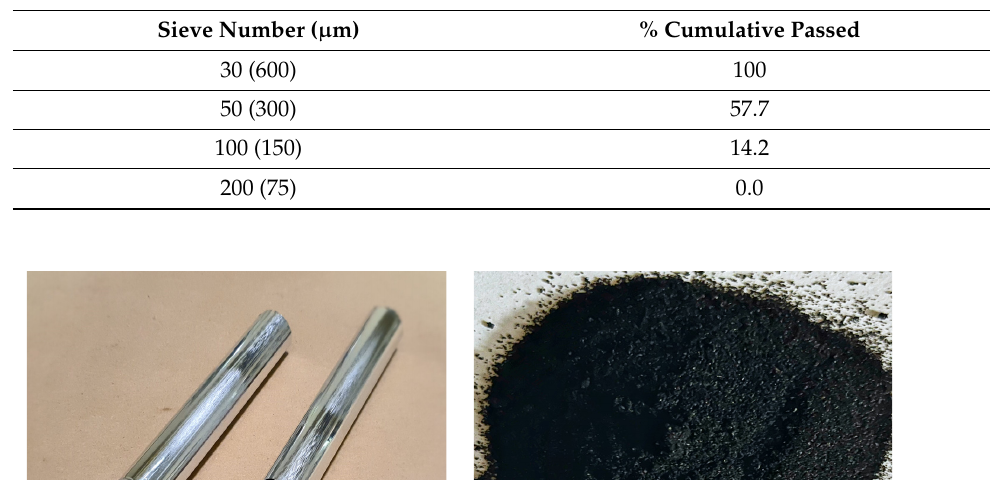
Table 2. Gradation of Crumb rubber modifier adopted in this study.